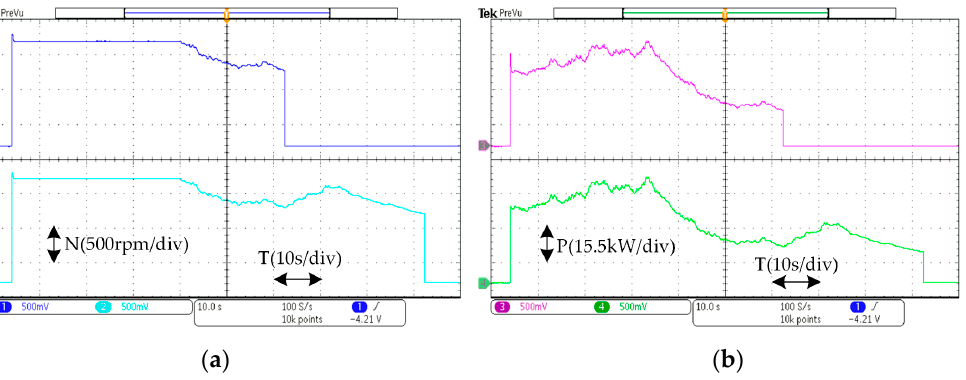
Figure 25. Speed and power curves of G1 and G2 under irregular waves. ( a ) Speed curve of G1 and G2; ( b ) power curve of G1 and G2.